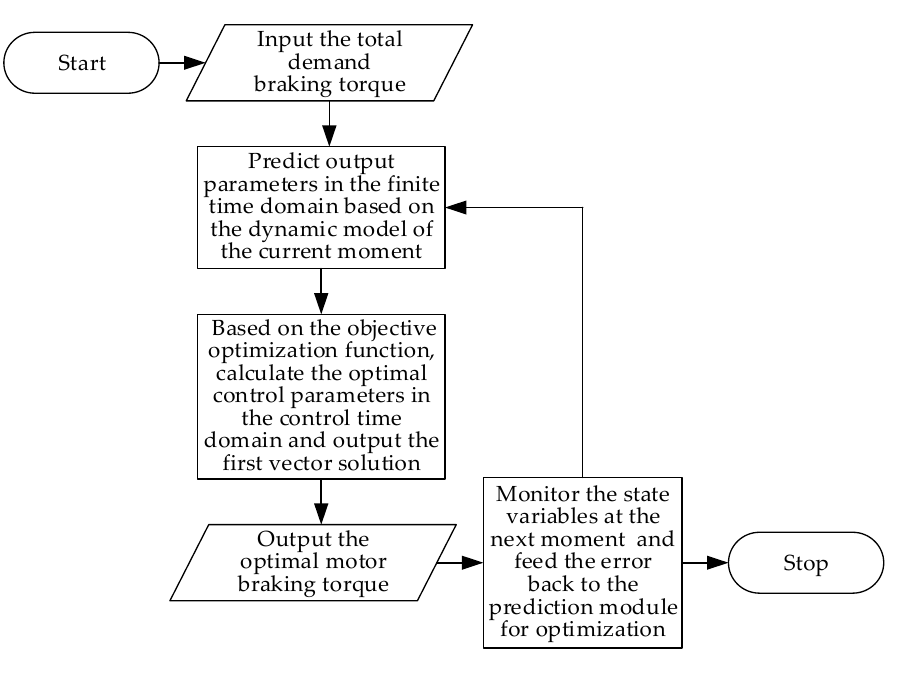
Figure 2. The nonlinear model predictive control process.